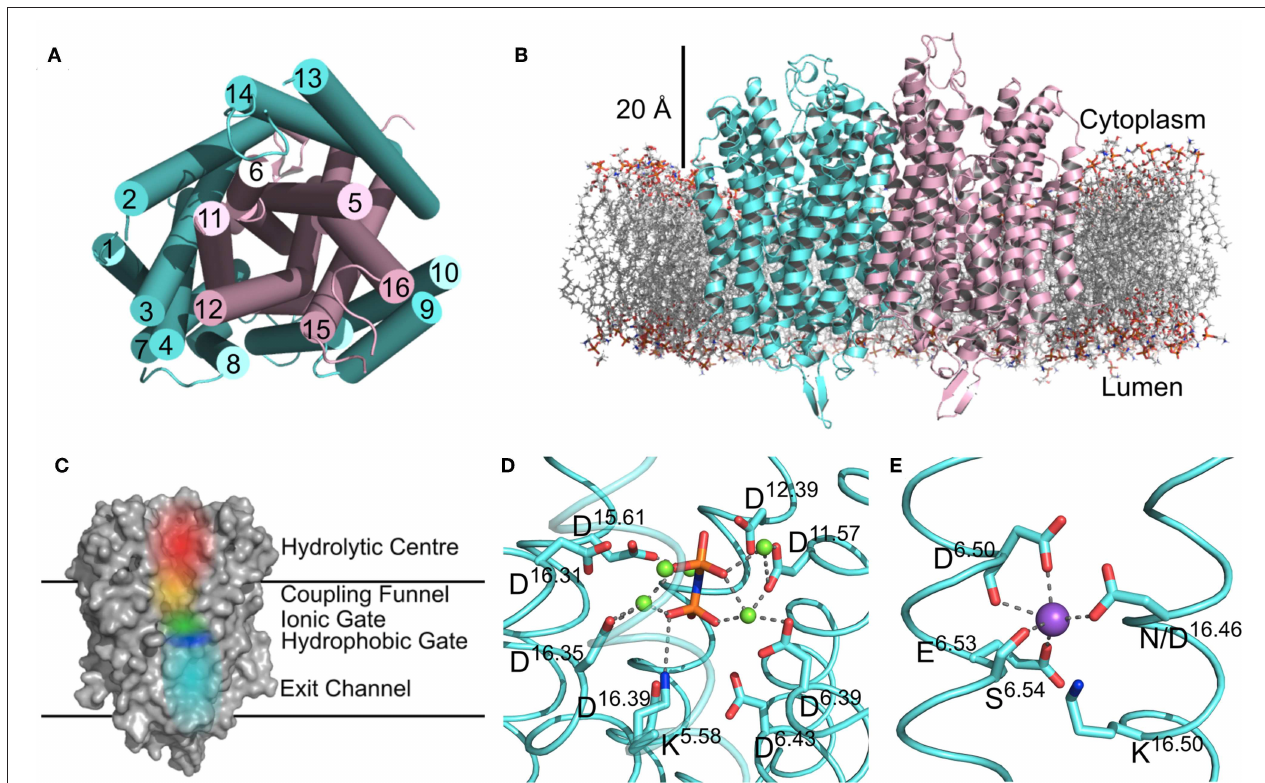
FIGURE 1 | Structural Features of mPPases. (A) The concentric ring arrangement of the 16 helices in one mPPase subunit, as viewed from the cytoplasmic side. (B) The dimeric protein and its positioning in the lipid bilayer viewed from the membrane plane. The mPPase subunits are colored cyan and pink. (C) A surface view of one mPPase subunit with each of the catalytic regions colored (red, hydrolytic center; yellow, coupling funnel; green, ionic gate; dark blue, hydrophobic gate; light blue, exit channel). The coordination of (D) IDP and Mg 2 + (green spheres) in the hydrolytic center and (E) of Na + (purple sphere) at the ionic gate. Figures generated using PyMol ( DeLano, 2002) and the IDP-bound Tm- PPase structure (PBD: 5LZQ) (Li et al., 2016).